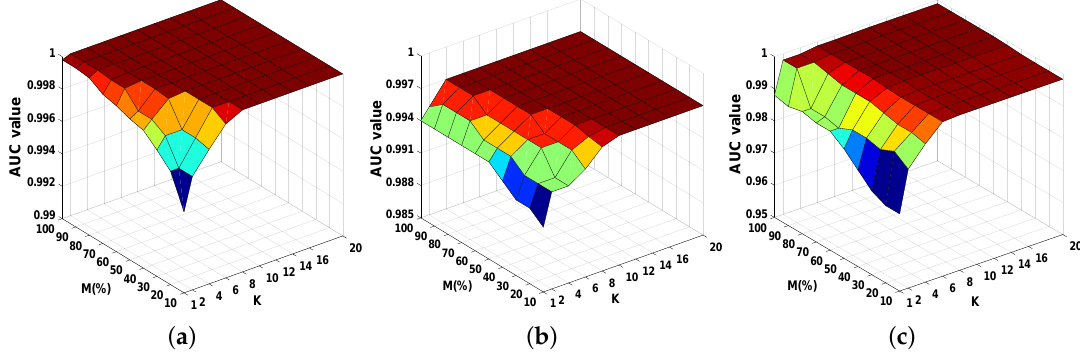
Figure 20. AUC illustration of DCLaAW with different combinations of K and M for each dataset. ( a ) Synthetic dataset; ( b ) San Diego dataset; ( c ) Urban dataset.